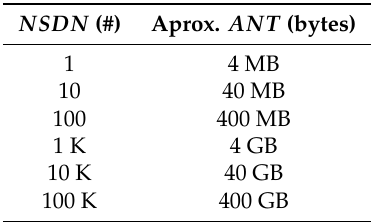
Table 8. Projected daily network traffic